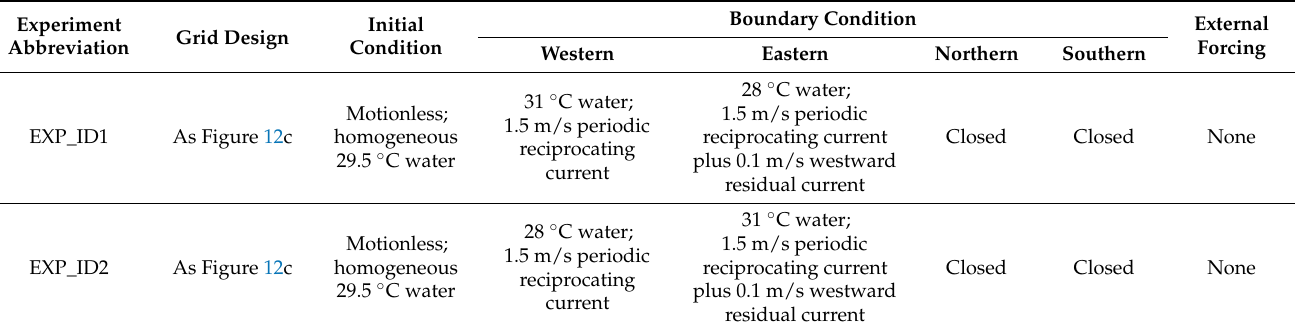
Table 3. Key configurations of idealized numerical